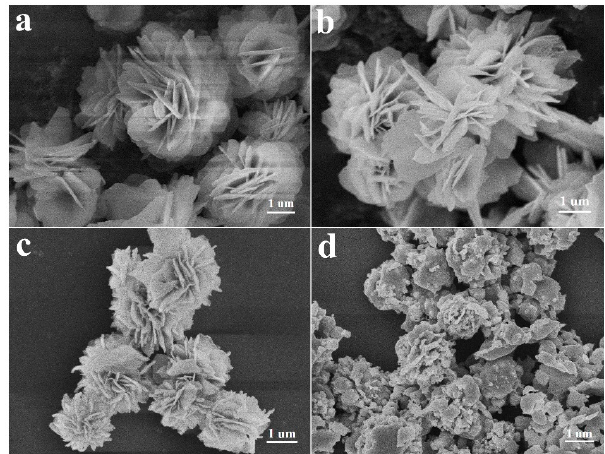
Figure 2. Typical SEM image of as-prepared Fe-based precursor ( a ); α -Fe 2 O 3 ( b ); F-FeS ( c ); and B-FeS ( d ).